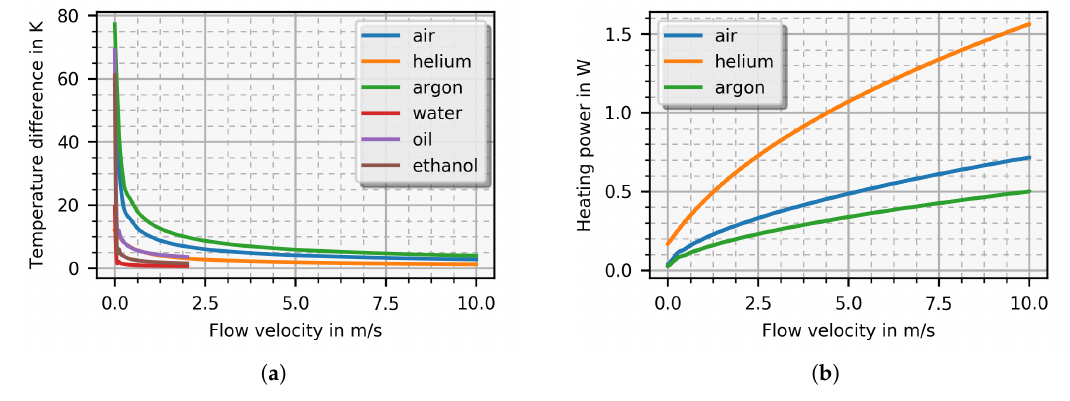
Figure 3. Simulation results for different test fluids: ( a ) Temperature difference versus the mean flow velocity at 1W heating power for gases and 3W for fluids; ( b ) Simulated heating power of several gases versus the mean flow velocity, which is need to maintain a 2K temperature